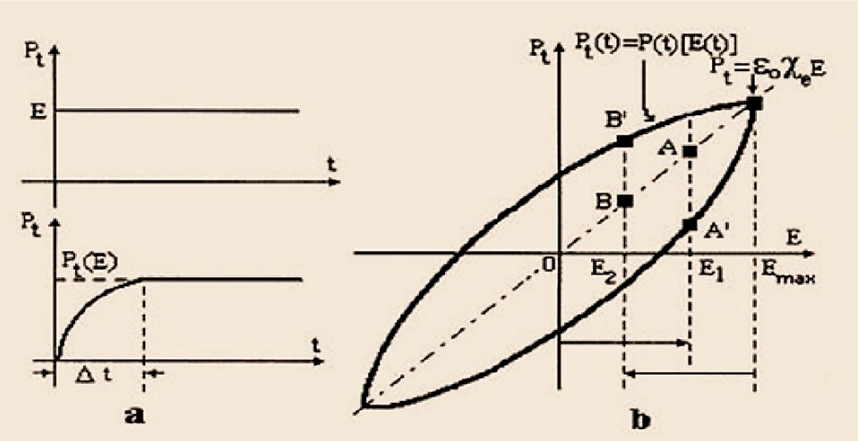
Figure 11. Diagrams associated with the after-effect of the electric field applied to linear dielectrics at: ( a ) sudden variations, ( b ) sinusoidal [42].